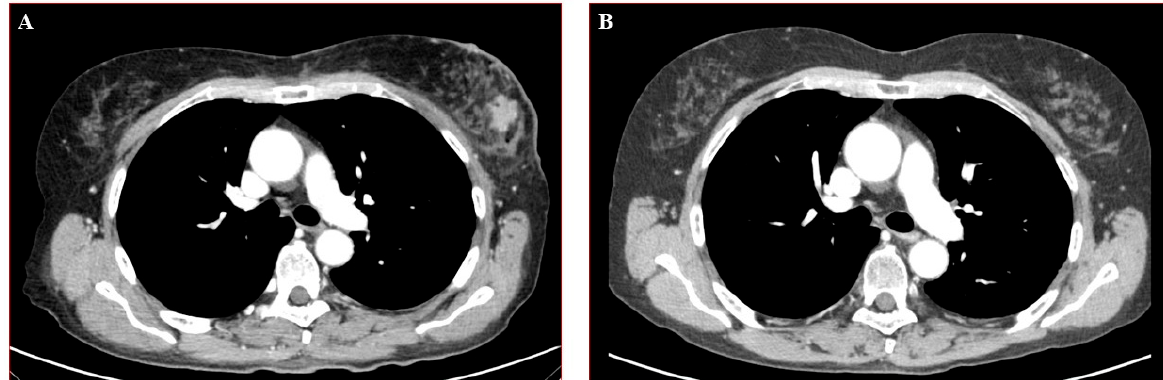
Figure 1. Radiological complete response documented at pre ( A ) and post ( B ) neoadjuvant treatment images.